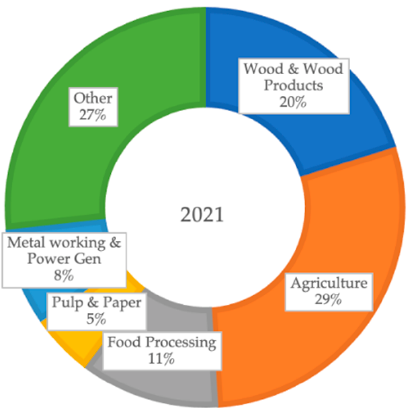
Figure 6. Dust fire and explosion incident breakdown according to the industry in 2021 [69]. Figure 7 illustrates the five main components to initiate a dust explosion. Over